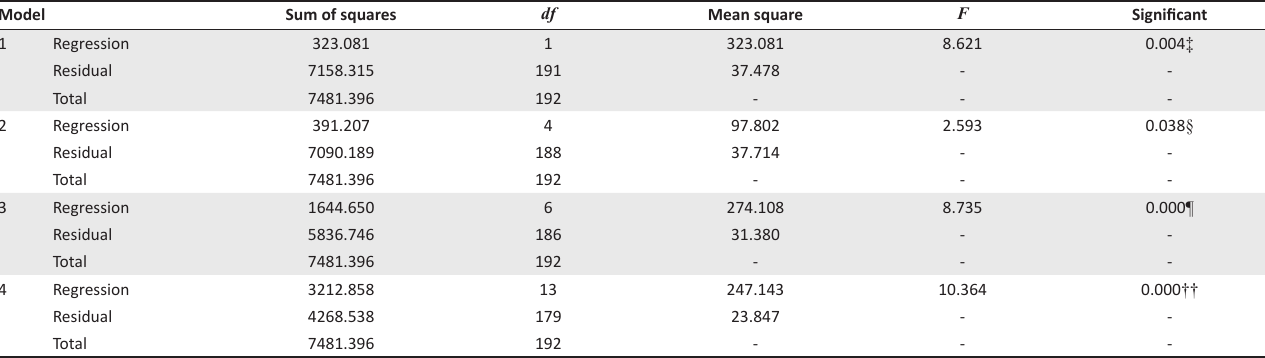
TABLE 3: Analysis of variance. † Model Sum of squares df 1 Regression Residual Regression Residual